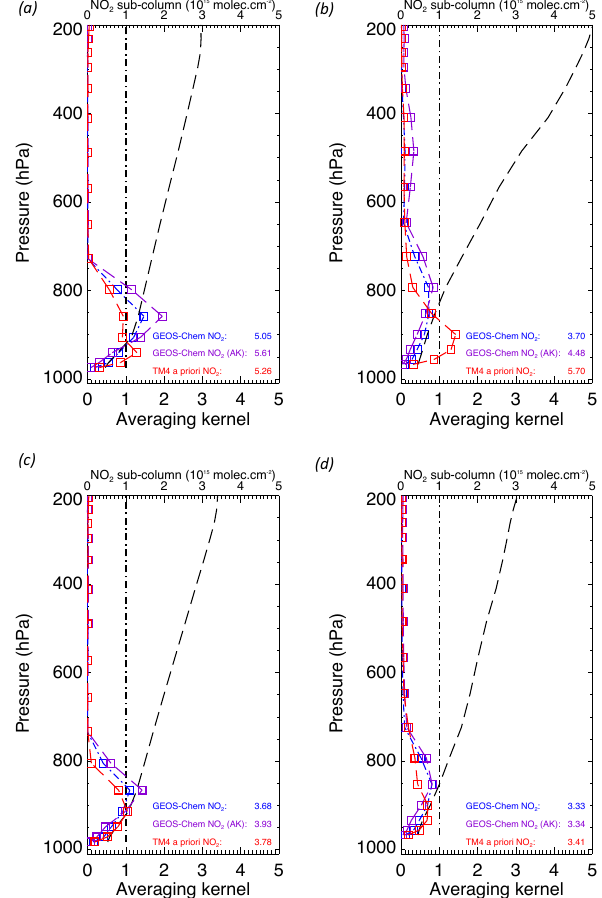
Figure 6. Vertical averaging kernel (black dashed line) and NO 2 profiles simulated by GEOS-Chem (blue), TM4 (red, a priori pro- files in OMI NO 2 retrieval), and GEOS-Chem convolved with the averaging kernel (purple) following Eq. (6): (a) 18 February 2006, (b) 23 August 2006 over the Beijing grid cell (centered on 40 ◦ N, 116.25 ◦ E), (c) 17 February 2006, and (d) 31 August 2006. The numbers given in blue, purple, and red indicate the tropospheric vertical NO 2 columns in GEOS-Chem and